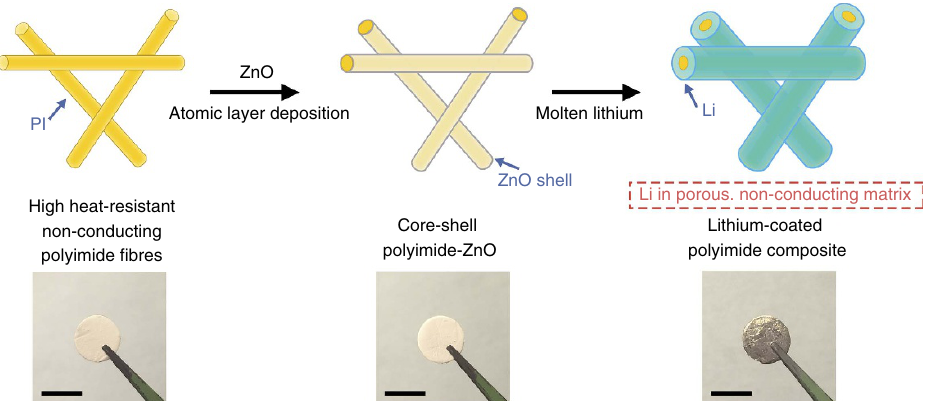
Figure 1 | Schematic of the fabrication of the Li-coated PI matrix. Electrospun PI was coated with a layer of ZnO via ALD to form core-shell PI-ZnO. The existence of ZnO coating renders the matrix ‘lithiophilic’ such that molten Li can steadily infuse into the matrix. The final structure of the electrode is Li coated onto a porous, non-conducting polymeric matrix. Scale